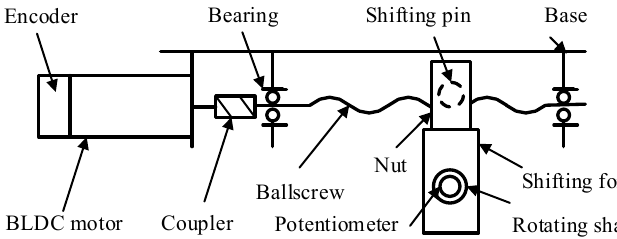
Figure 1. The diagrammatic sketch of the EMA system.